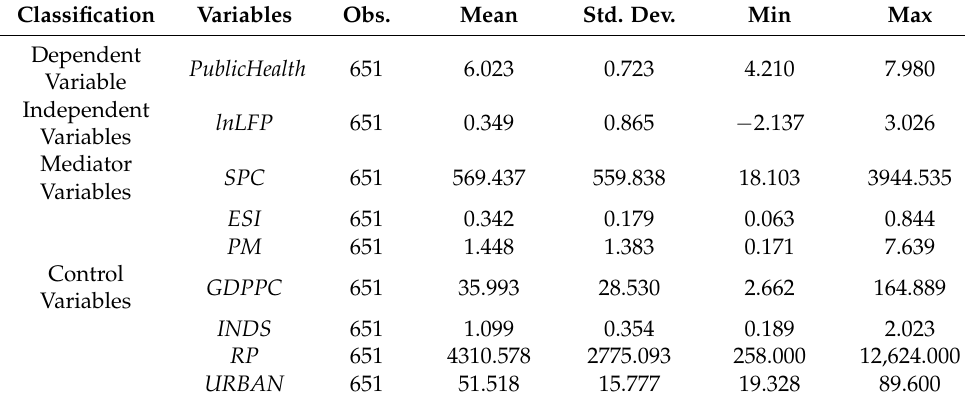
Table 1. Descriptive statistics of the